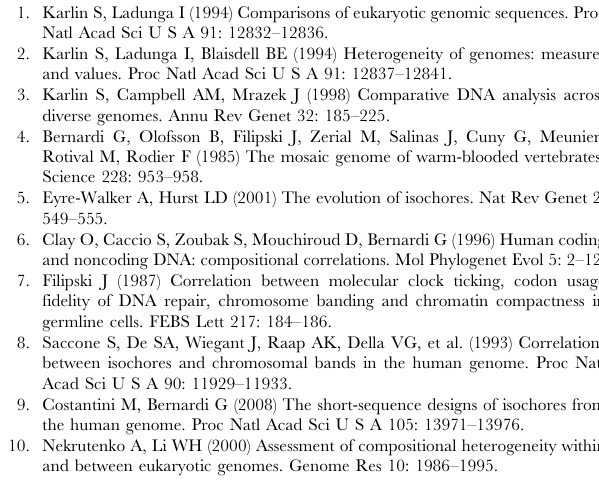
Figure S27 Linear fitting of the dinucleotide biases of Oryza , Arabidopsis , Physcomytrella and Selaginella. Table S1 ( a ) Break points and slopes of the ensemble graphs for Oryza sativa. Slopes are expressed in bp/Kbp. (b) Percentage of significant fitting to the segmented and linear regression for Ozyza sativa . Table S2 ( a ) Average trinucleotide bias of Arabidopsis coding sequences. The trinucleotide contents were calculated for each window position and averaged over all sequences longer than 2 kb using a window of 99 bp. The c index were calculated according to Karlin [2]. (b) Average trinucleotide bias of Oryza coding sequences. The trinucleotide contents were calculated for each windoe position and averaged over all sequences longer than 2 kb using a window of 99 bp. The c index were calculated according to Karlin [2]. Table S3 Average trinucleotide bias of intron sequences. The trinucleotide contents were calculated for each window position and averaged over all sequences. Table S4 Average trinucleotide bias of Physcomytrella and Selaginella coding sequences. The trinucleotide contents were calculated for each windoe position and averaged over all sequences longer than 2 kb using a window of 99 bp. The c index were calculated according to Karlin